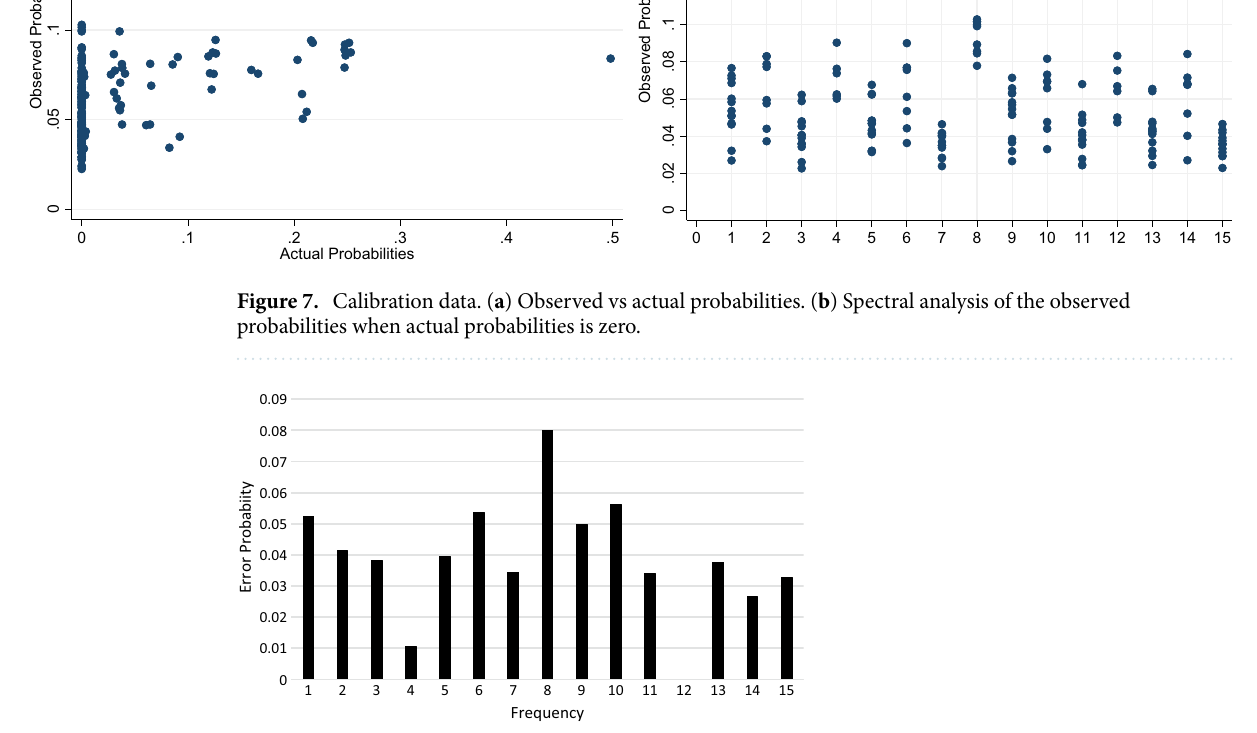
Figure 8. Error probabilities for each frequency